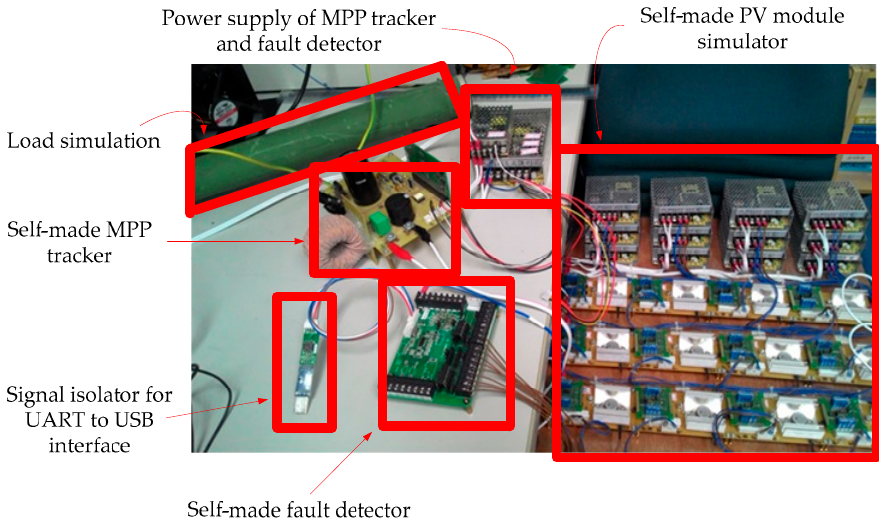
Figure 15. Hardware exterior of the proposed fault diagnosis system for PV module.